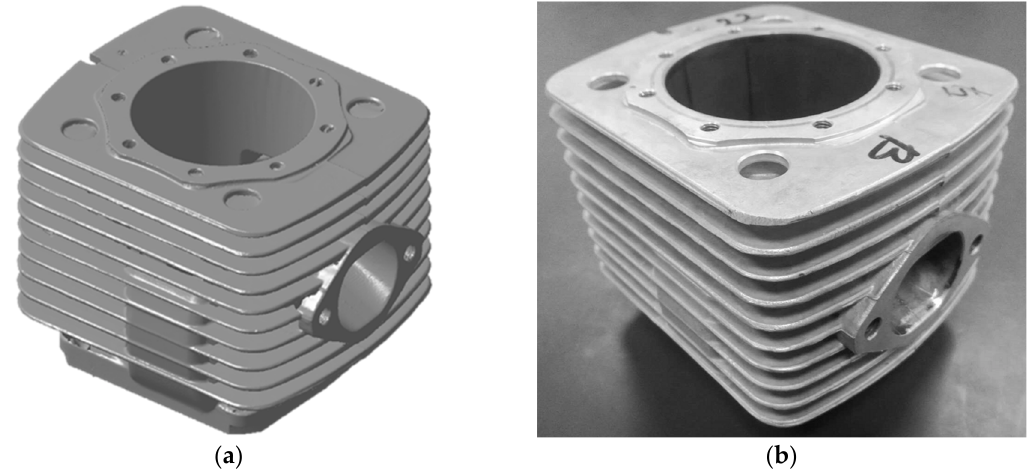
Figure 6. Comparison of the engine cylinder. ( a ) Reconstruction computer aided design (CAD) result; ( b ) actual part.